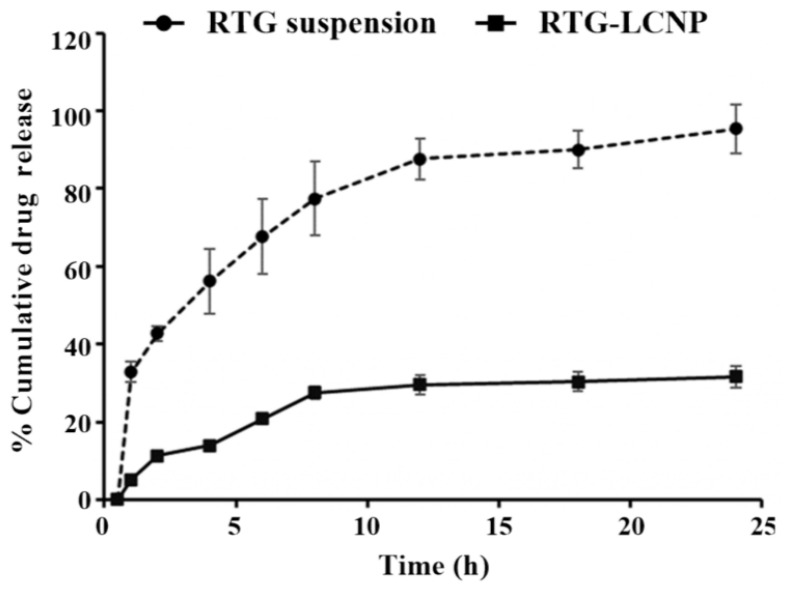
Figure 5. In vitro release profiles of RTG suspension and optimized RTG-LCNP (LCNP 15) in PBS (pH 7.4).